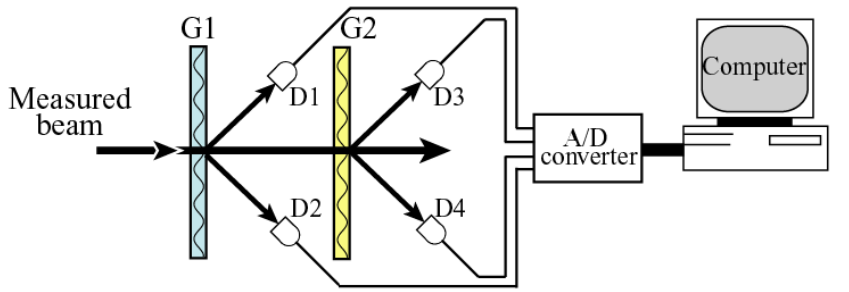
Figure 10. Fundamental configuration of a polarimeter (Stokesmeter) using two anisotropic gratings.